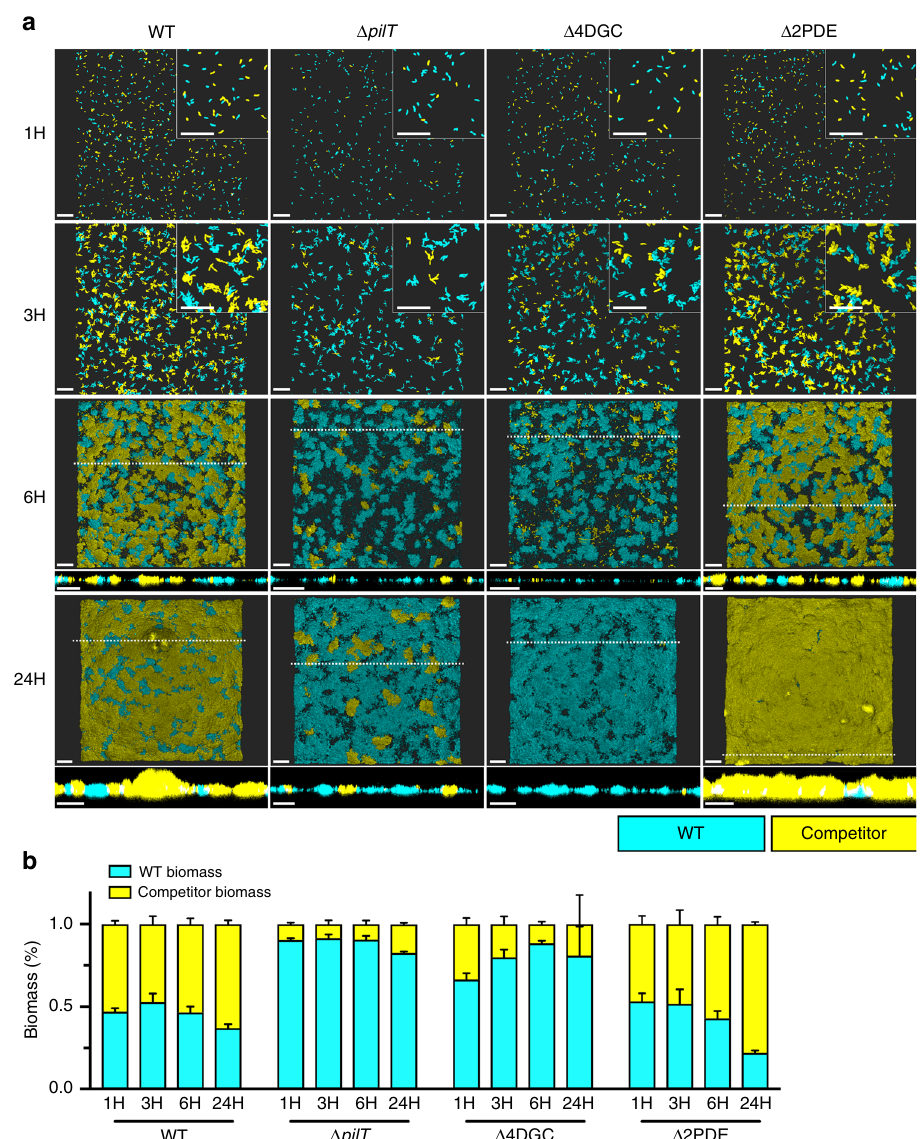
Fig. 7 MSHA extension and retraction dynamics dictate surface attachment and bio fi lm production in a model of competition. a Representative images of fl ow cell bio fi lm competition experiments with WT::RFP (cyan) and WT::/mutant::GFP (yellow) strains, at stages corresponding to the monolayer stage (1 H), microcolony formation (3 H), three-dimensional microcolony development (6-H), and mature bio fi lm (24 H). Insets in the upper right corner of 1- and 3-h images are zoomed in views obtained from the same image to depict single cells and micro-colonies. Images at 6- and 24-h include a cross- sectional image of the XZ plane, and the position from which this cross-section was obtained is indicated in the image by the dashed-line. Images representative of 2 independent analyses. Scale bars = 20 μ m. b WT::RFP (cyan) and competitor (WT::/mutant::GFP, yellow) biomass levels presented as a percentage of the overall biomass. Biomass levels determined using Comstat2, and the percentage of the GFP-biomass from the whole was determined at each time point and plotted as the mean from two biological replicates imaged at ×10 magni fi cation (with three technical replicates per biological replicate and time point) with error bars indicating the standard error of the mean. Raw Comstat2 determined values are provided in Supplementary Table 1. Source data provided as a Source Data fi